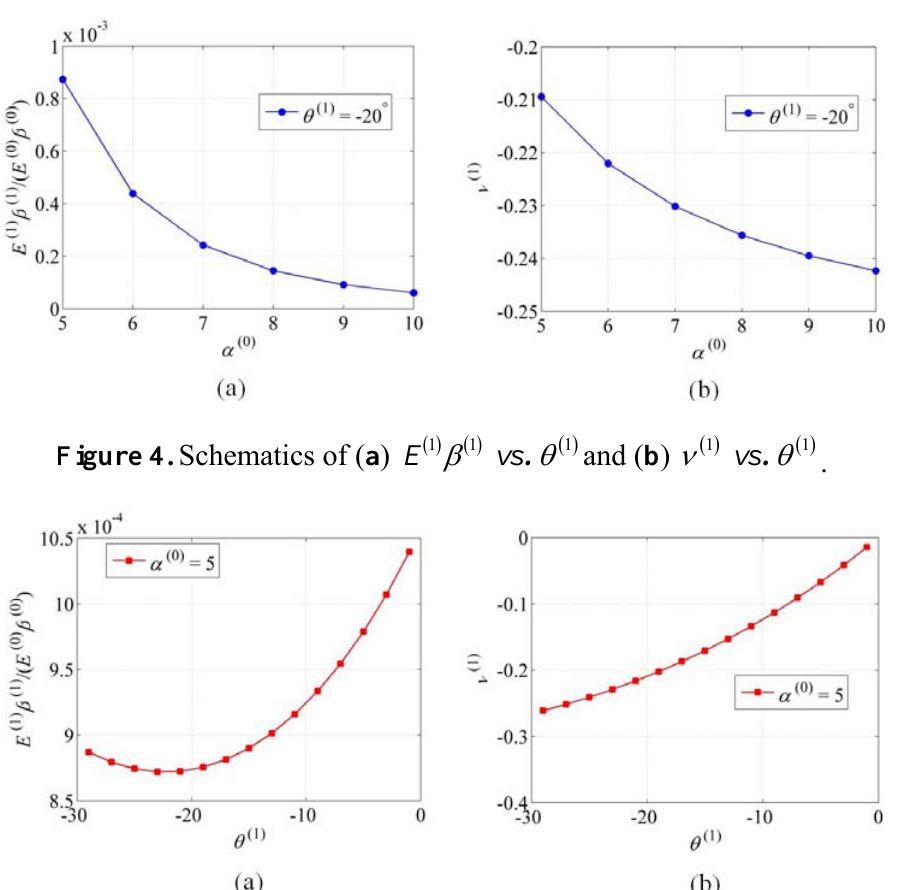
Figure 3. Schematics of ( a )